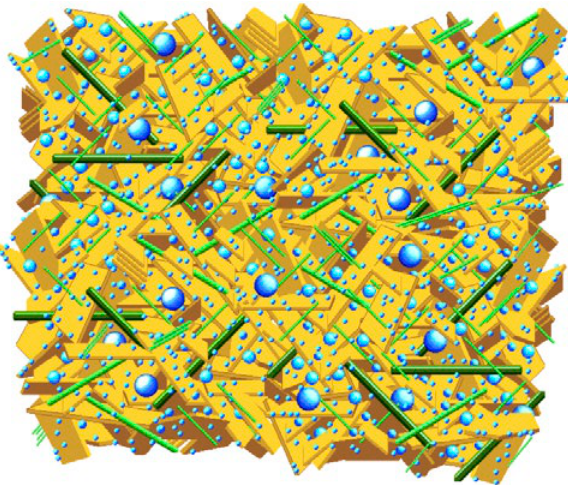
Figure 43. Initially flocculated sediments compact to a relatively random initial aggregate of mixed particles.